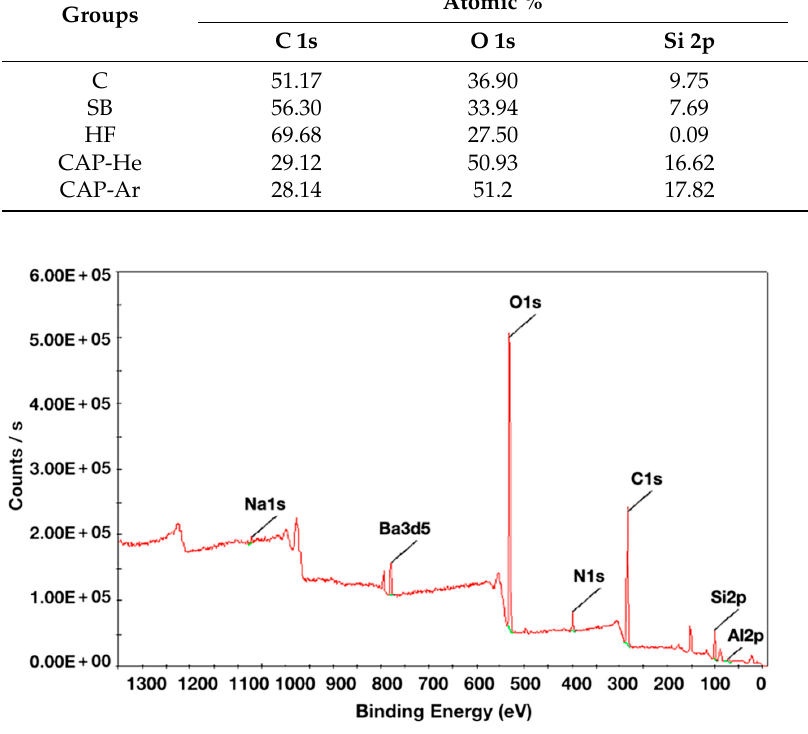
Figure 5. XPS wide-scan spectra of RNC specimen. Table 4. Main chemical compositions on RNC surfaces.